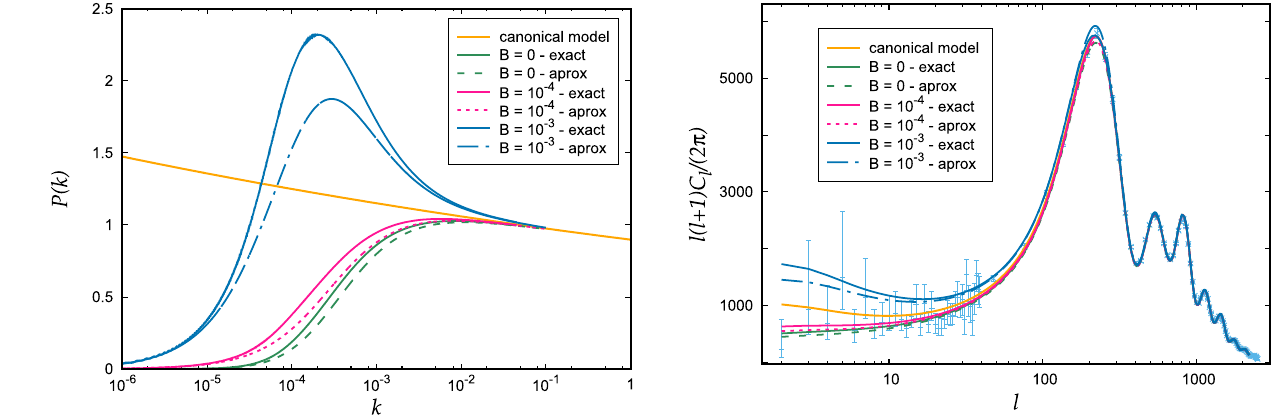
Fig. 1 PrimordialpowerspectrumfortheEUmodelincludingtheCSL proposal. Here we set a 0 H 0 = 2 × 10 − 4 from [164] and consider dif- ferent values of the B parameter (units in Mpc − 1 ). Solid line represents the exact formula, while dashed line corresponds to the approximate expression. The canonical model is also plotted as a reference. The PPS which results from the CSL model tends to the canonical model for some scale between 0 . 01 < k < 0 . 1. The green lines correspond to